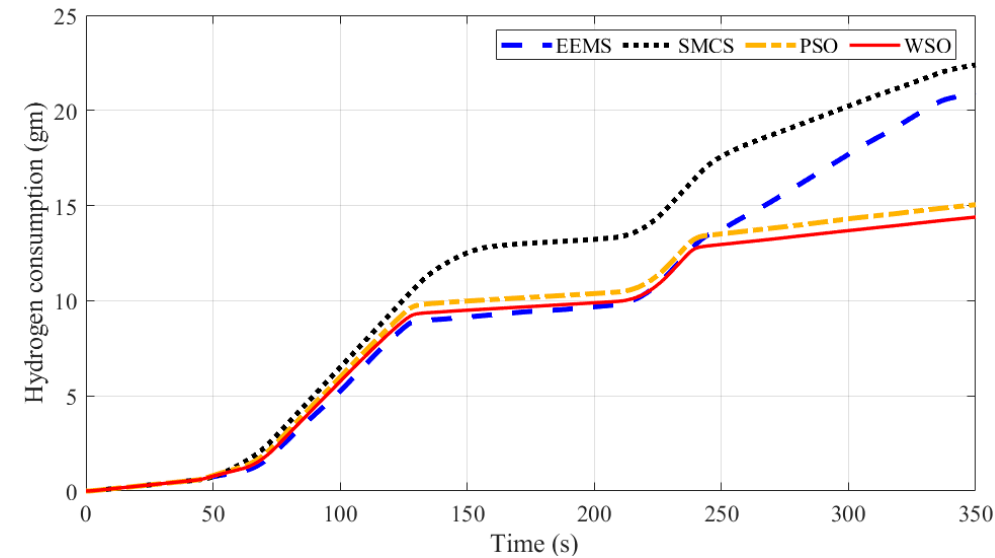
Figure 12. Time response of SC voltage obtained using different EMSs.